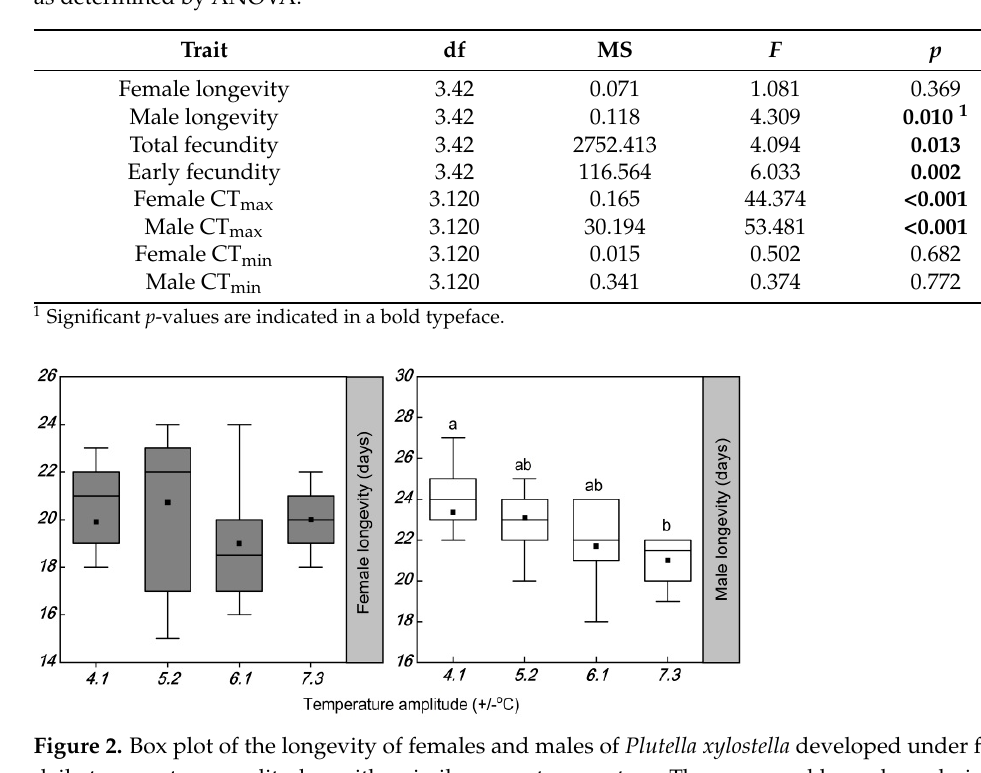
Table 4. Effects of the daily temperature amplitude (DTA) on female and male Plutella xylostella traits as determined by ANOVA.